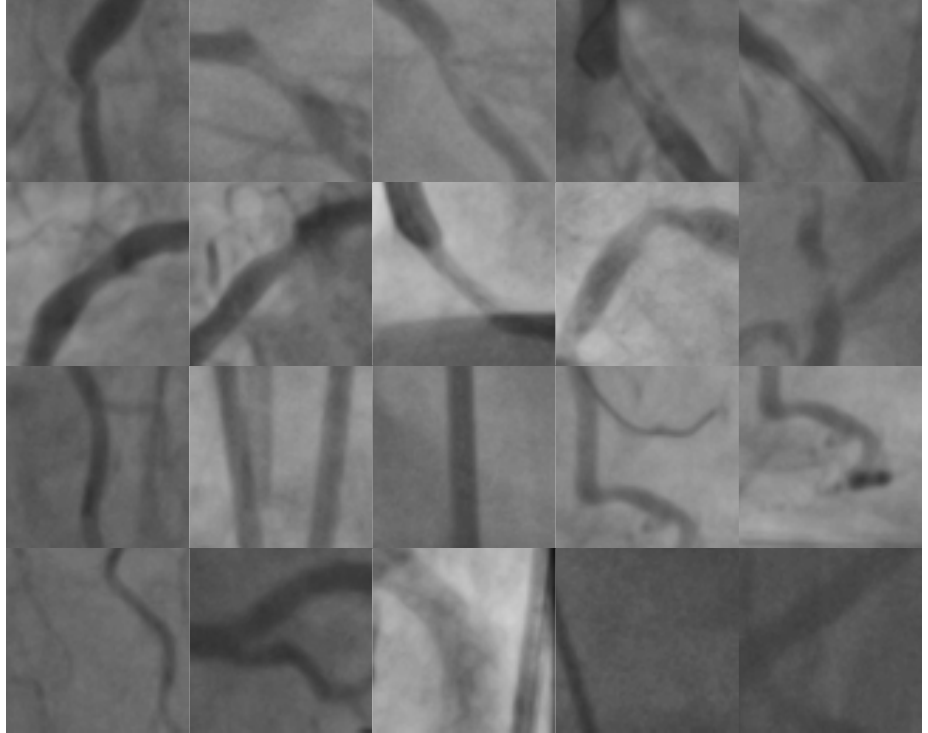
Figure 4. Patch samples with positive stenosis cases (first and second rows) and negative cases (third and fourth